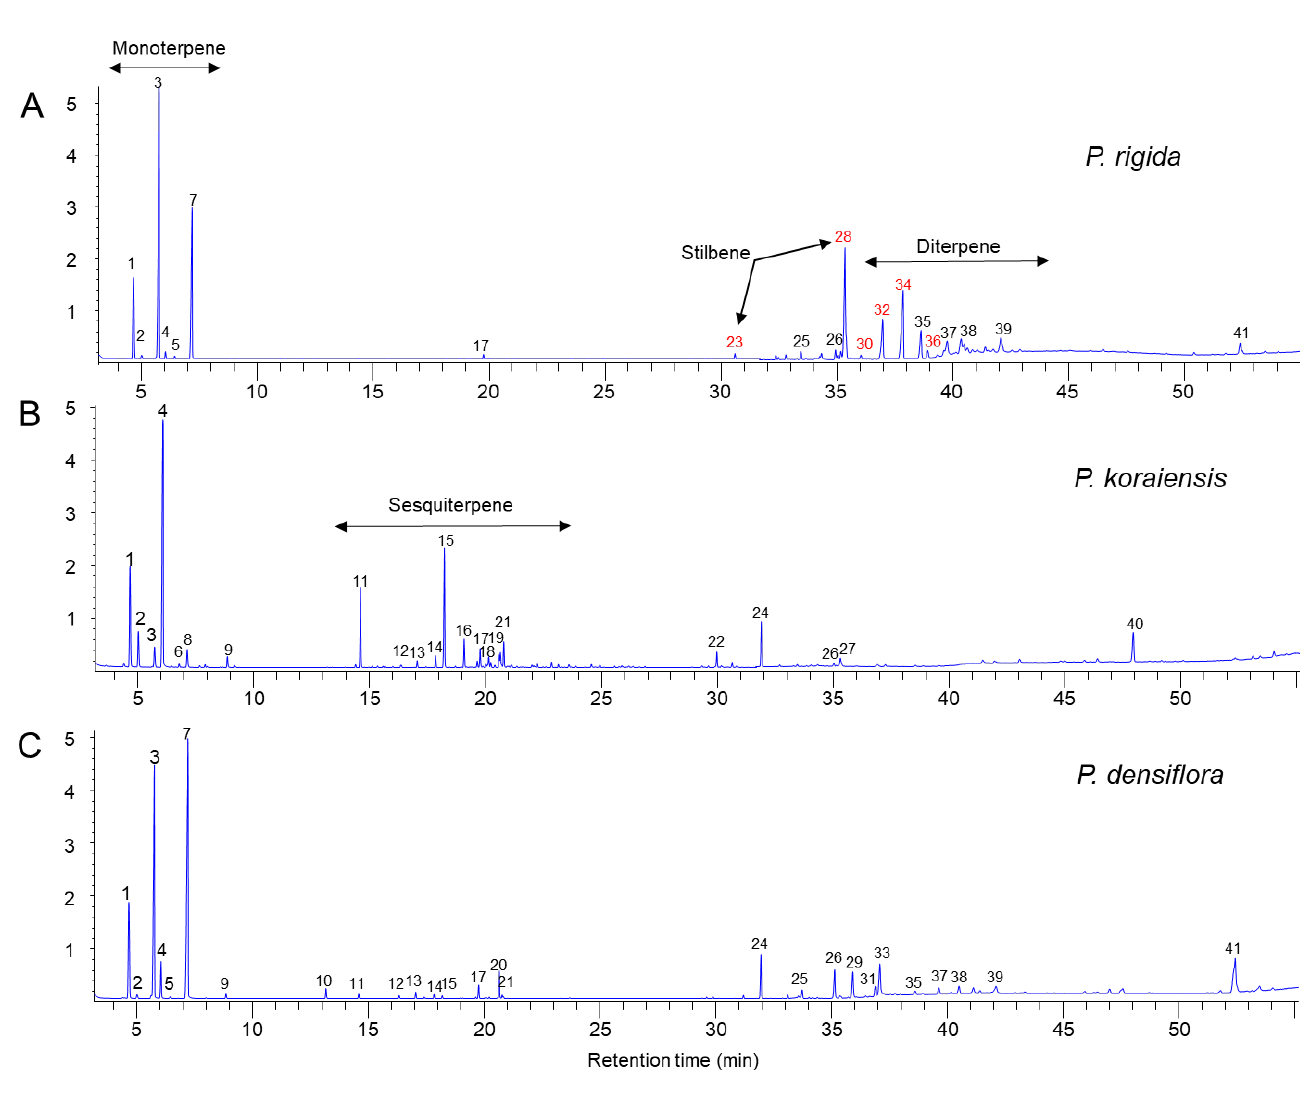
Figure 4. Chemical composition in resin extracts of three Pinus species ( P. rigida, P. koraiensis, and P. densiflora ) by GC–MS analysis. ( A ) GC chromatogram of P. rigida resin. ( B ) GC chromatogram of P. koraiensis resin. ( C ) GC chromatogram of P. densiflora resin .